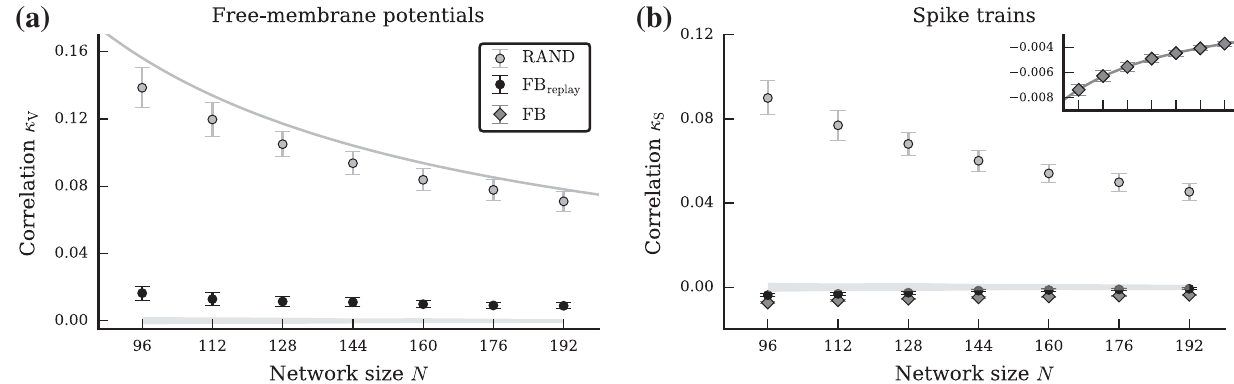
FIG. 7. Dependence of population-averaged input correlations (a) and spike-train correlations (b) on the network size N , for the intact network (FB, dark gray diamonds), the FB (black circles), and the RAND (light gray circles) cases (fixed in-degree replay K ¼ 15 ). Symbols and error bars denote mean and 1 standard deviation, respectively, across M ¼ 100 network realizations (error bars are partly covered by markers). The gray curve in (a) depicts shared-input correlations in a homogeneous network [Eq. (2)]. The inset in (b) shows a magnified view of the spike-train correlations in the FB case (dark gray diamonds) with a power-law fit ∼ N − 1 (dark gray curve). The light gray horizontal band represents mean (cid:3) 3 standard deviations of (spurious) correlations in surrogate data where correlations are removed. Note that free membrane potentials cannot be recorded in the FB case (see Sec. II). Hence, there are no gray diamonds in (a).